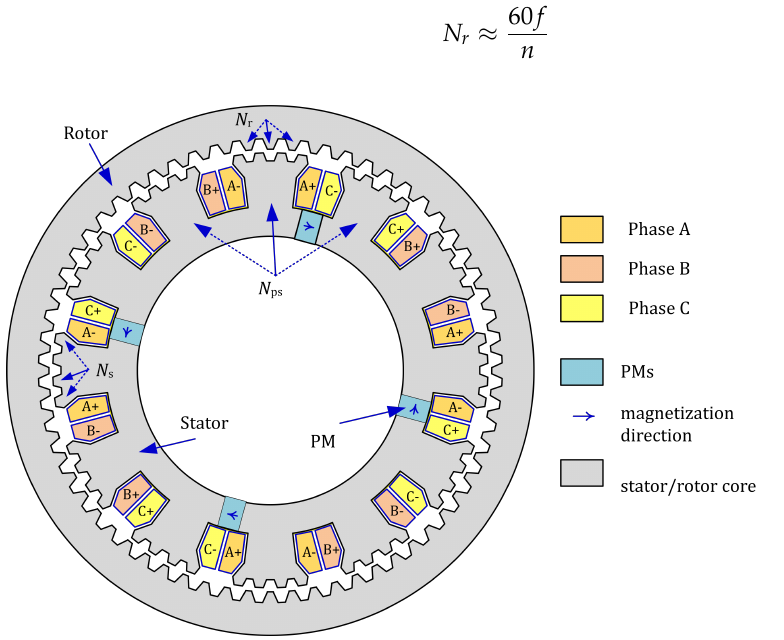
Figure 2. Cross-section and constructional details of outer rotor toothed doubly salient permanent magnet generator (ORDSPMG) under